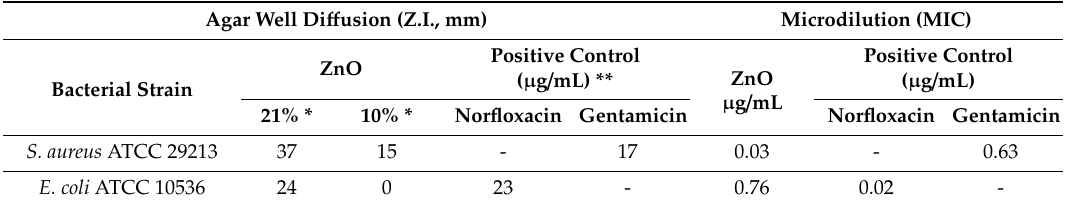
Table 3. Antibacterial activity of colloidal ZnO nanoparticles.